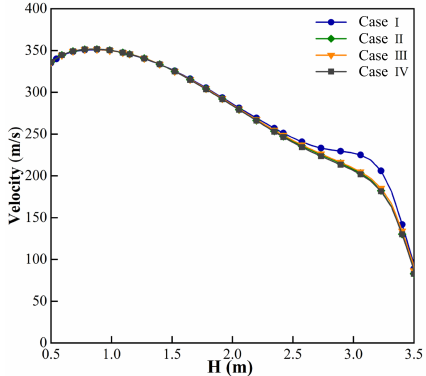
Figure 3. Velocity distribution for different mesh